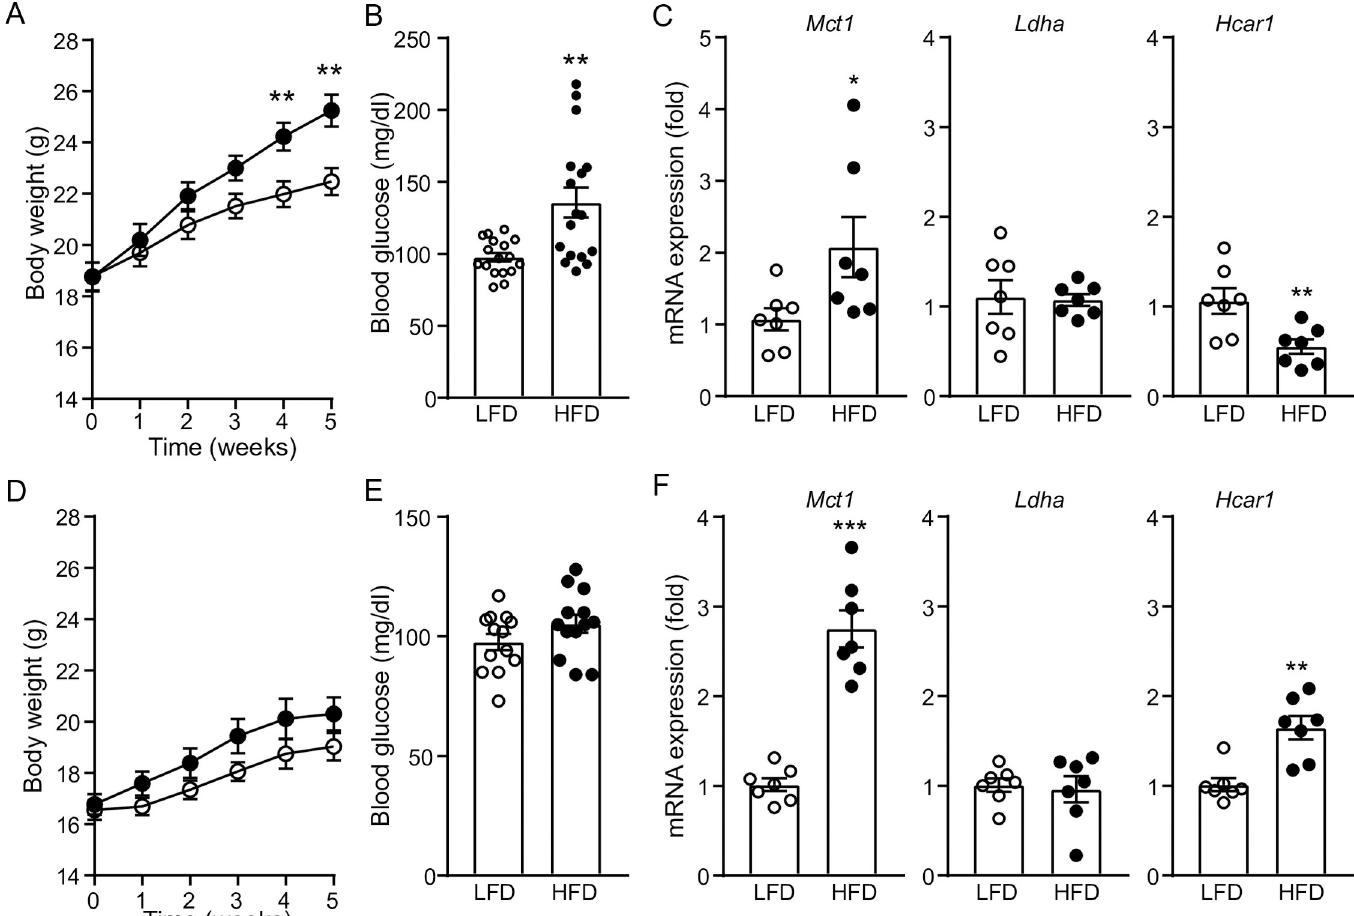
Fig 1. High-fat feeding differentially regulates Hcar1 gene expression in male and female mice. A and B. Summary graphs showing changes in body weight and fasting glucose levels in male C57BL/6J mice fed LFD (open circle) and those on HFD (filled circle). Male mice fed HFD for 5 weeks at 28˚C developed DIO and hyperglycemia (mean fasting blood glucose concentrations: LFD, 97.8 ± 3.0 mg/dl, HFD, 135.8 ± 10.4 mg/dl, n = 17 mice, respectively, �� p < 0.01). C . Summary plot showing altered expression of the genes required for lactate release and its cognate receptor in male mice fed HFD for 5 weeks (n = 7 and 7 mice / group, respectively, � p < 0.05, �� p < 0.01). D and E . There were no differences in body weight and blood glucose levels in female mice fed either LFD or HFD for 5 weeks (mean fasting blood glucose concentrations: LFD, 97.7 ± 3.4 mg/dl, HFD, 105.3 ± 3.8 mg/dl, LFD, n = 13 mice; HFD, n = 13 mice). F . Summary plot showing altered expression of the genes required for lactate release and its cognate receptor in female mice fed HFD for 5 weeks. High-fat feeding significantly upregulated Hcar1 mRNA expression (n = 7 and 7 mice / group, �� p < 0.01, ��� p < 0.001).